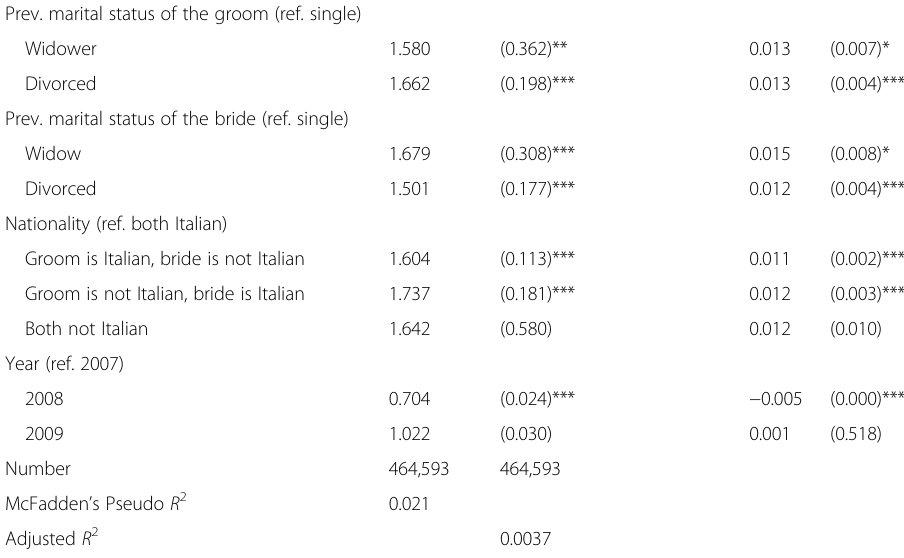
Table 5 Socio-demographic characteristics associated with the choice of marrying during the Lenten period: results from a multivariate logistic regression. Italy, 2007 – 2009 (Continued) Prev. marital status of the groom (ref.